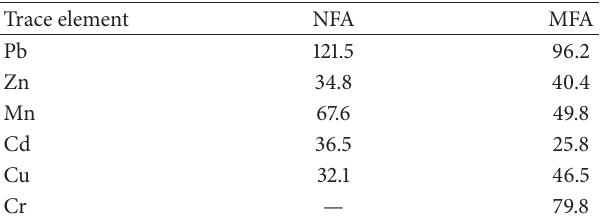
Table 4: Concentrations of trace elements in fly ashes